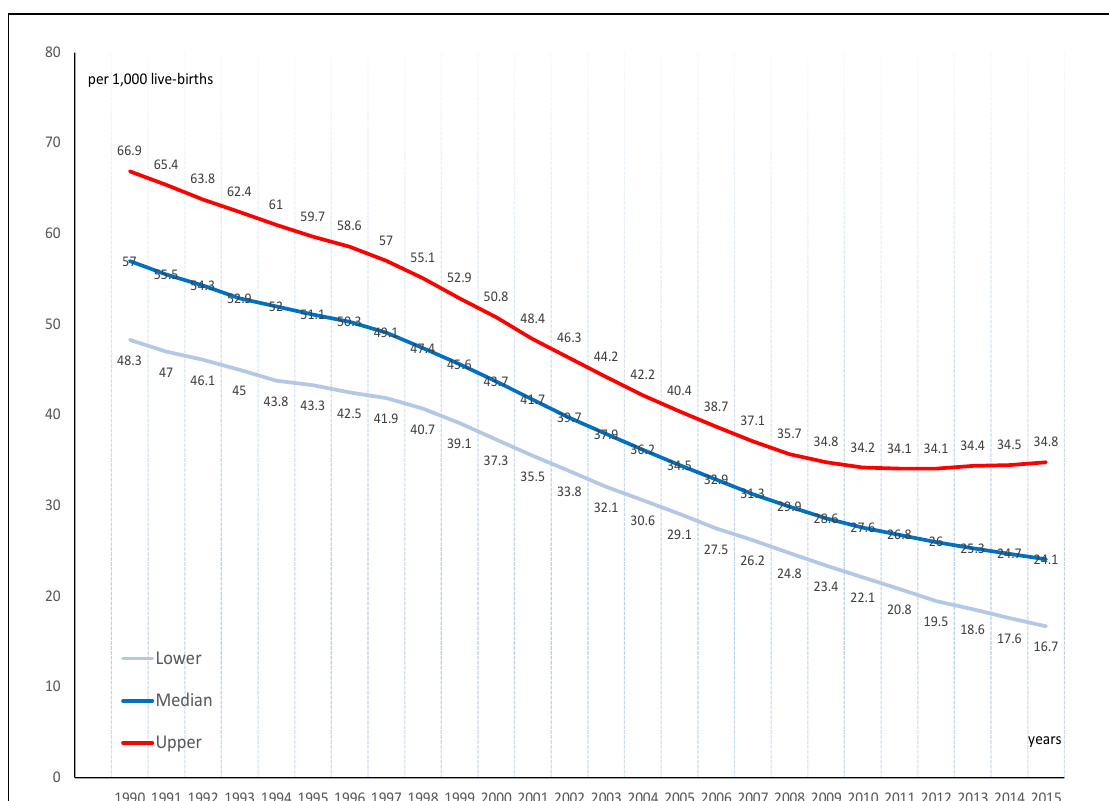
Figure 2. Neonatal Mortality Rate in Liberia